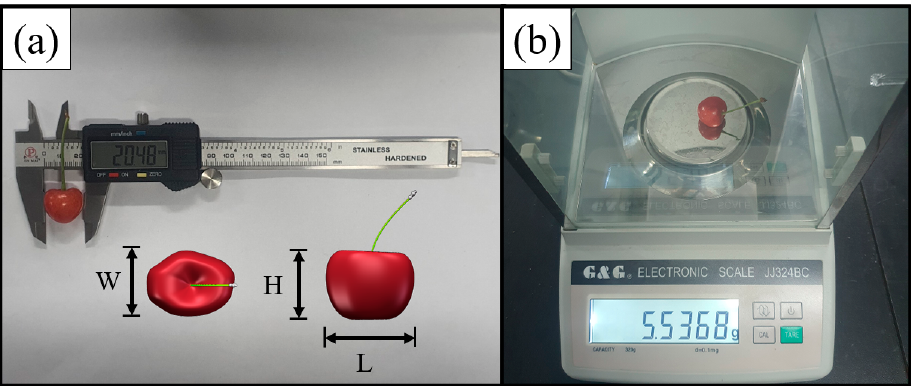
Figure 2. The geometric parameters of a sweet cherry: ( a ) size of sweet cherry and ( b ) mass of sweet cherry.